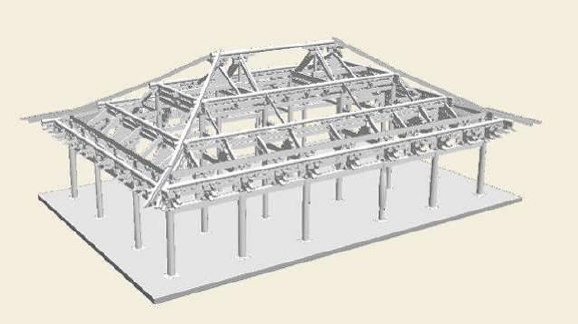
Figure 4 The whole wooden construction be regard as one object.